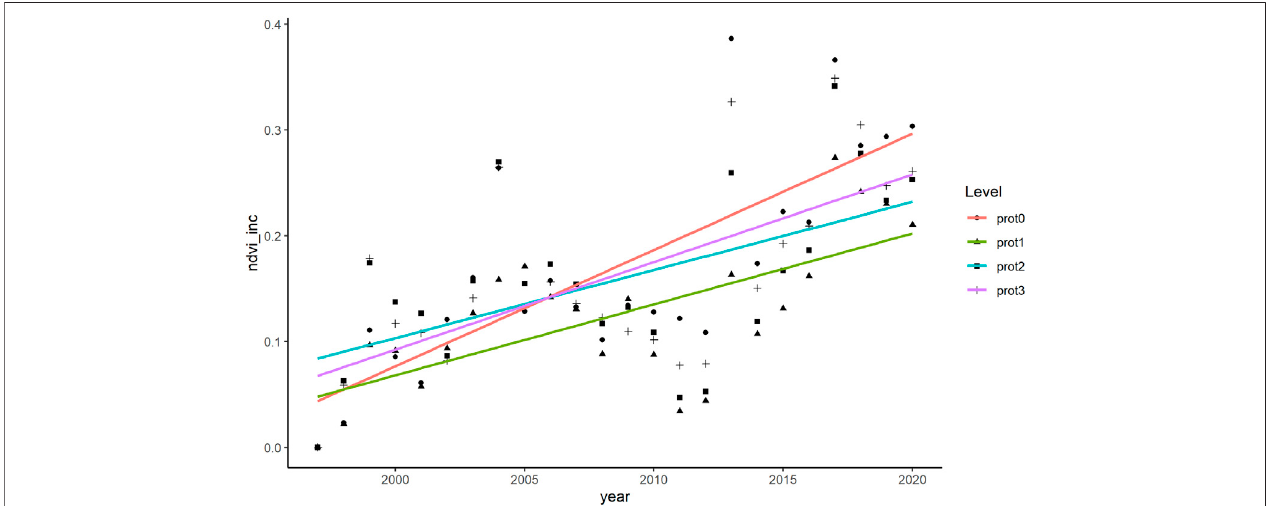
FIGURE 10 | Percent of area with an increase in NDVI, per level of protection, over time. prot0: unprotected area, prot1: National Reserve, prot2: National Park, prot3: Strict Nature Reserve.